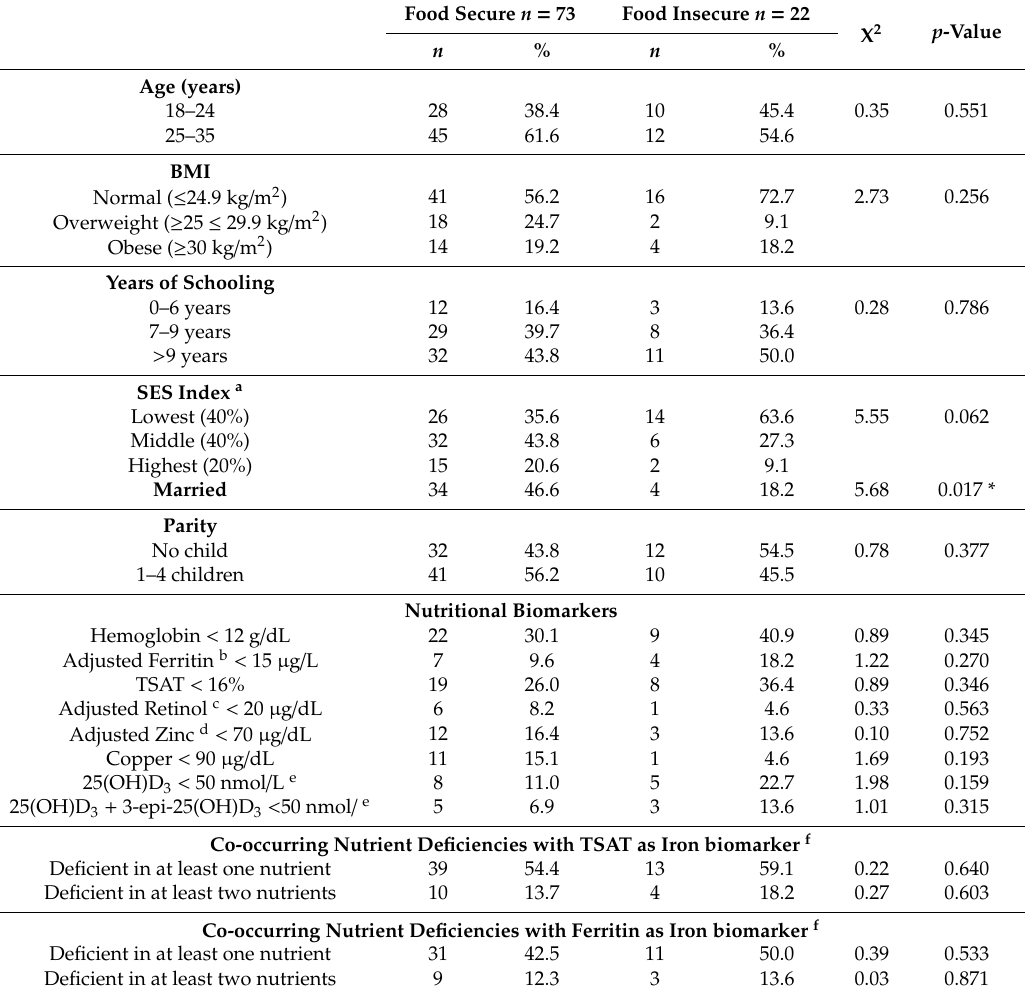
Table 1. Sociodemographic variables and micronutrient status of Ghanaian women categorized by food security